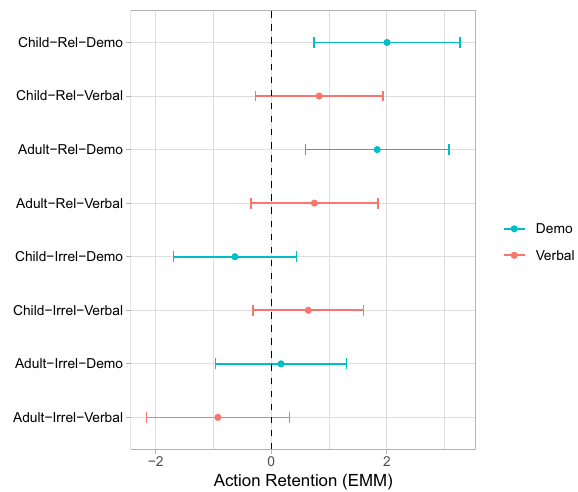
Fig. 4 Estimated marginal means (Log odds) with 95% CIs of action Retention for all combinations of the three predictors. Transmission mode (distinguished by colour for additional clarity), participant Age and action Relevance are shown.